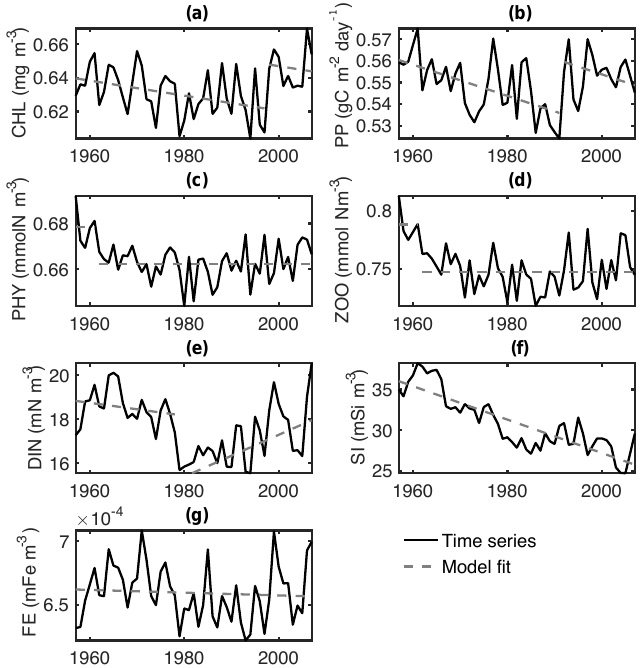
Figure B3. Time series of (a) surface chlorophyll, (b) integrated primary production, (c) total surface phytoplankton, (d) zooplankton biomass and (e) surface dissolved inorganic nitrogen, (f) silica and (g) iron simulated with the MEDUSA model and averaged over the Gulf of Alaska region. The dotted lines represent the statistical model